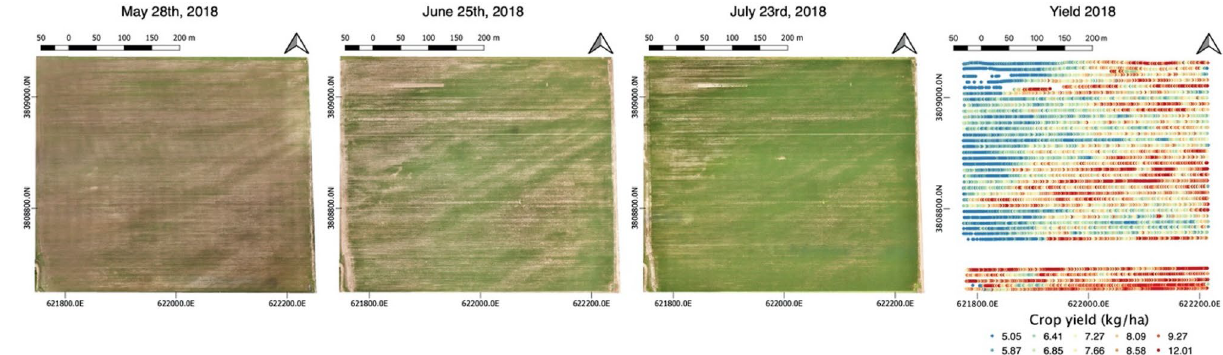
Figure 3. Time-lapse of UAV-RGB image acquired during the growing season (May 28th, June 25th, and July 23rd), and the point-cloud maps of the yield (kg/ha) acquired by the combine harvester (right figure). Maps made with QGIS (v 3.6, https:// www. qgis. org) 36